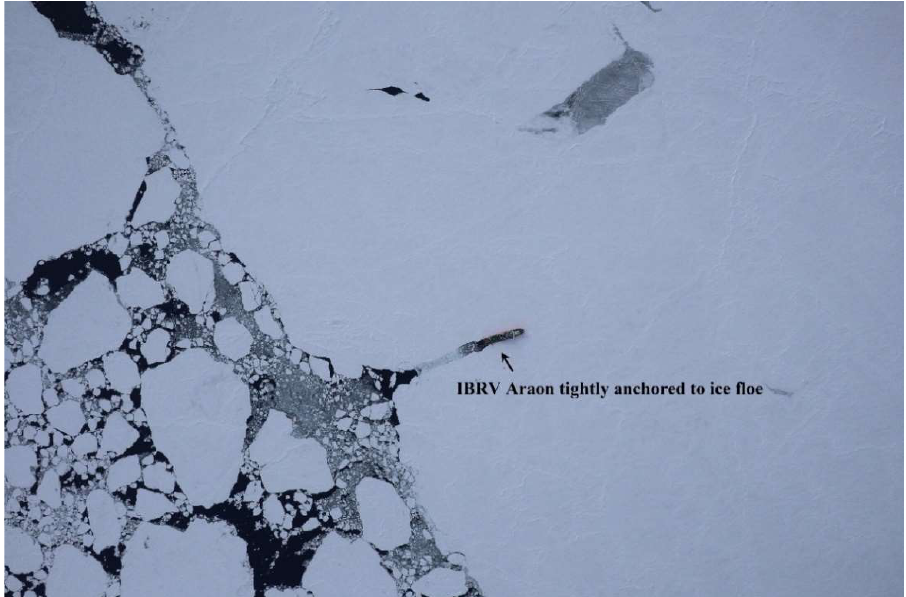
Figure 2. Aerial view of the sea ice floes where the field investigation was carried out on 13 – 15 August Figure 2.